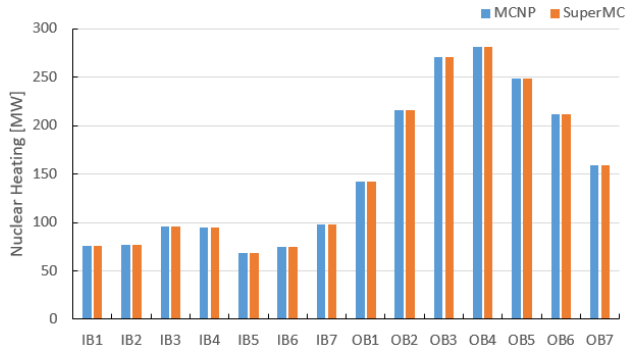
Figure 7. Profile of nuclear heating in blankets